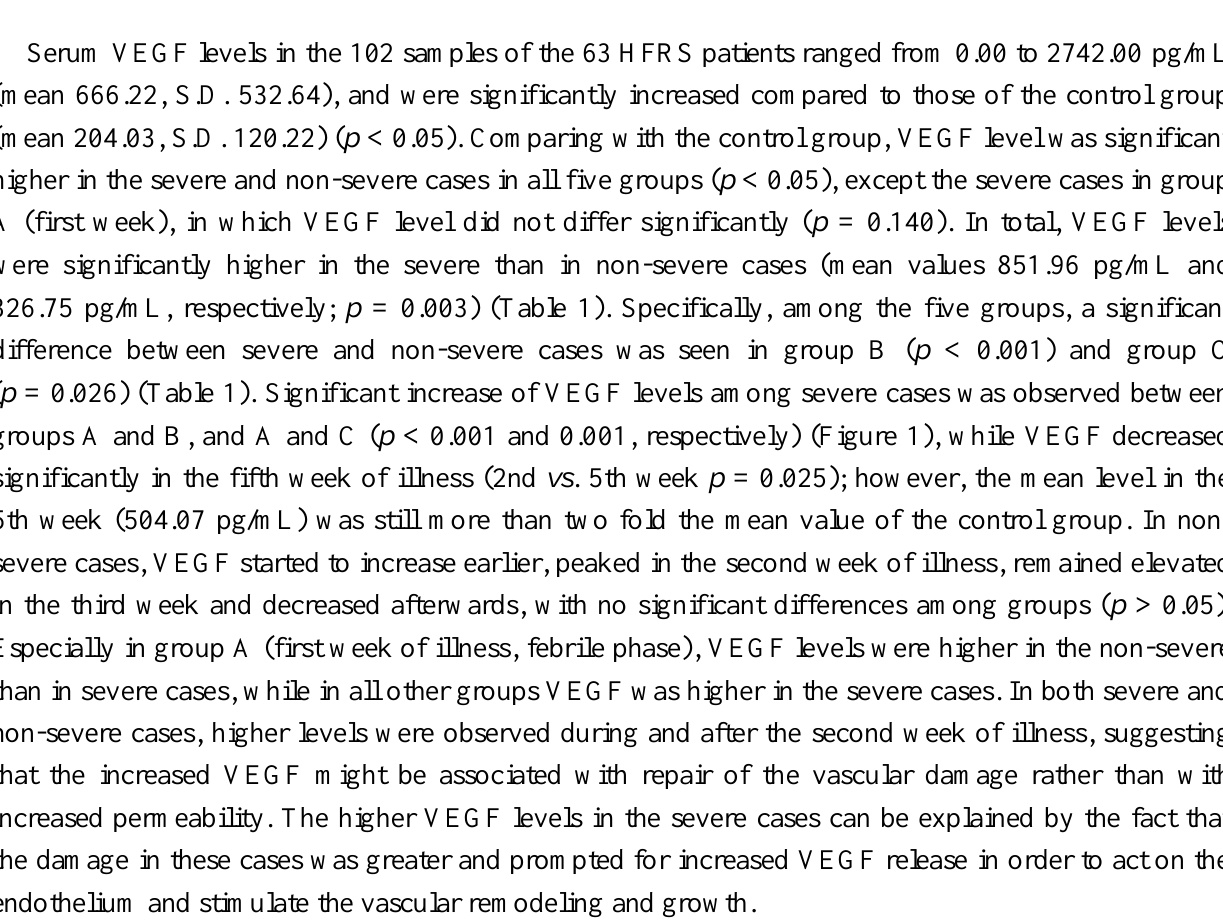
Table 1. Range and mean vascular endothelial growth factor-A (VEGF) levels (in pg/mL) in serum samples taken from severe and non severe hemorrhagic fever with renal syndrome (HFRS) cases grouped according to the day after the onset of illness: Group